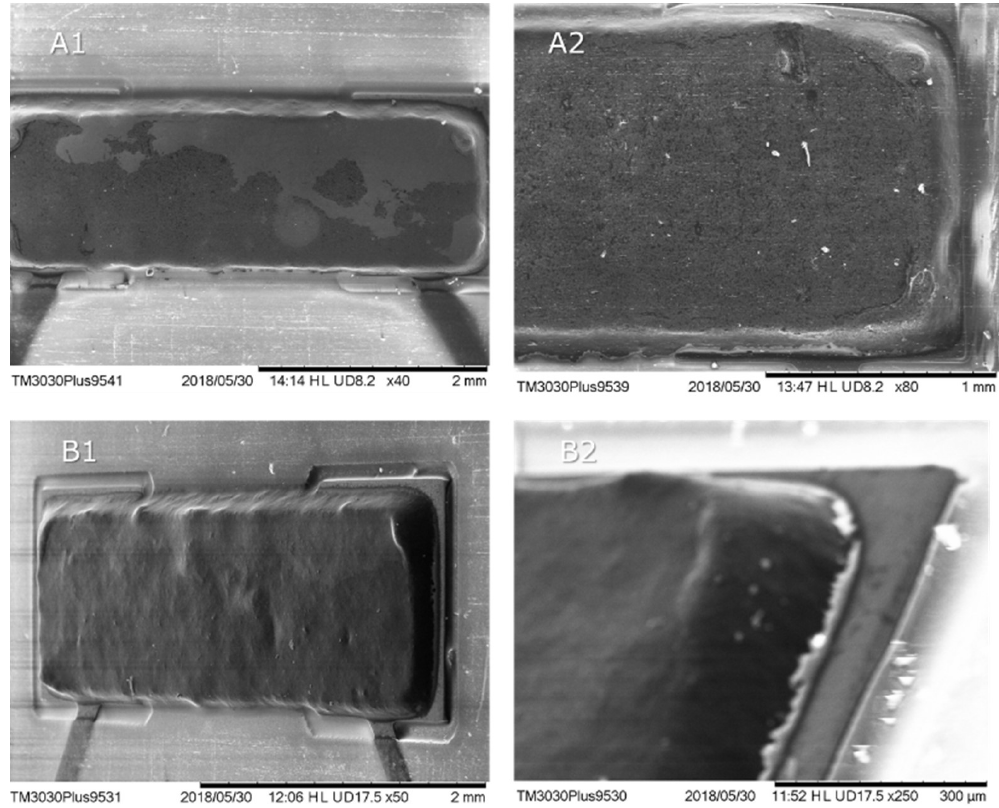
Figure 11. SEM images of screen-printed Adhesive A ( top ) on ImSn ( A1 ) and SSP ( A2 ) PCBs and Adhesive B ( bottom ) on ImSn ( B1 ) and SSP ( B2 ) PCBs.